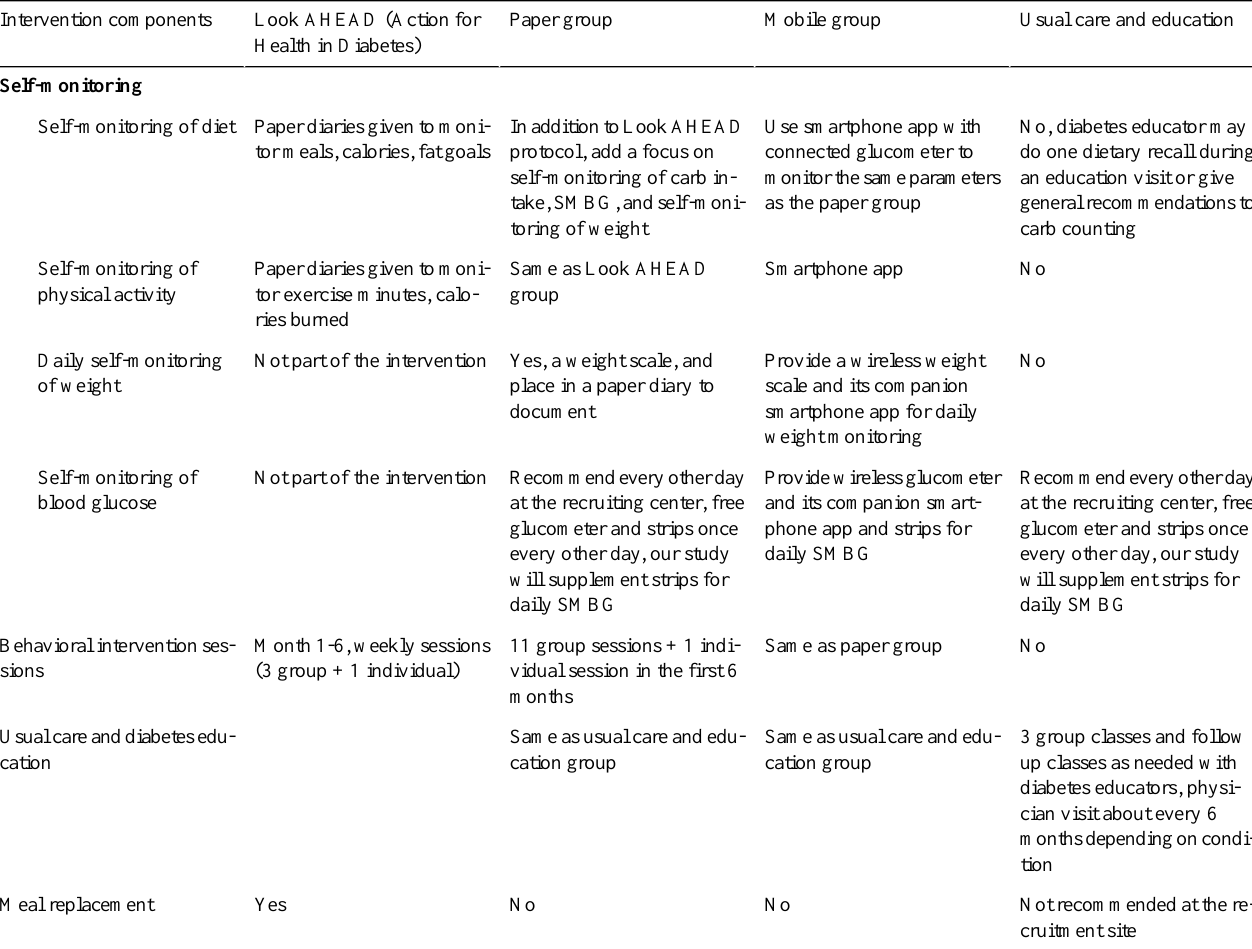
Table 1. Comparison of key intervention components among three randomization groups and standard behavioral lifestyle intervention used in the landmark Look AHEAD (Action for Health in Diabetes) trial. SMBG: self-monitoring of blood